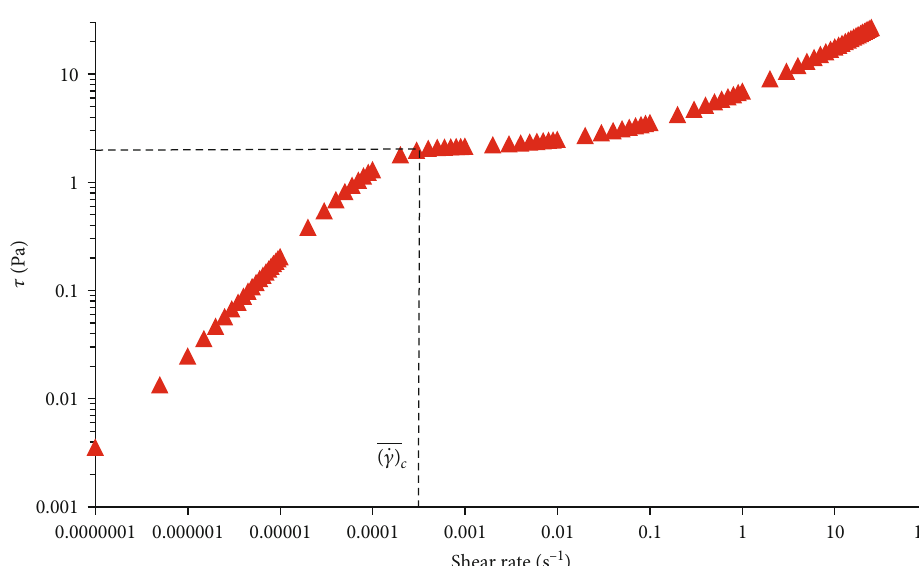
Figure 1: Relationship between shear force and shear rate.